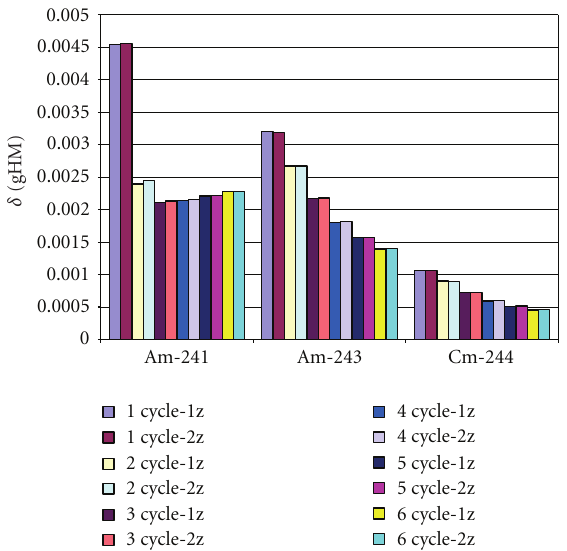
Figure 9: Production/destruction of some Am and Cm nuclides per initial HM mass in the di ff erent GCFR core models, for each recycle.